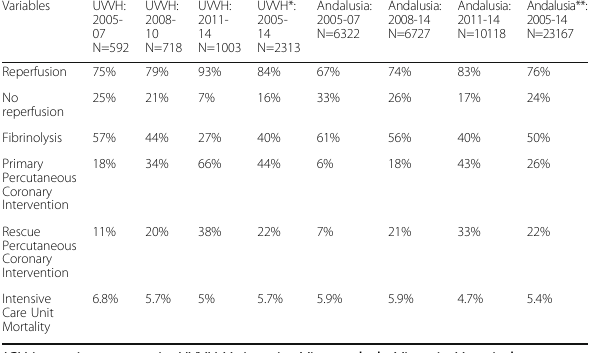
Table 64 (abstract A191). Ten-year evolution of reperfusion strategies Variables